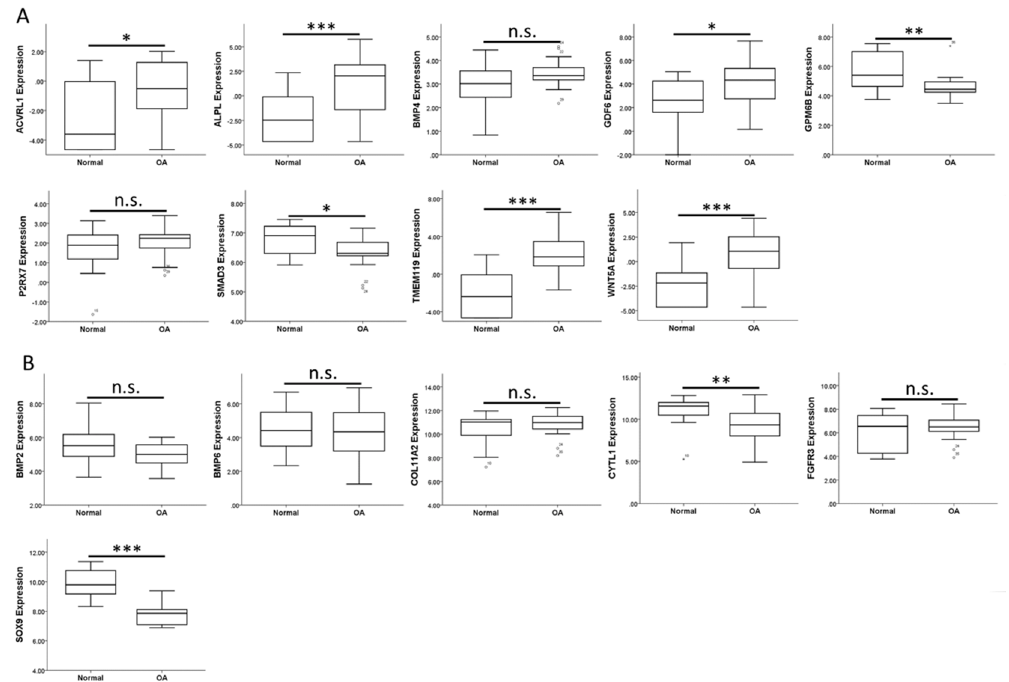
Figure 2. Expression patterns of genes related to the biological processes of OA in the GEO dataset of OA knee cartilages. The expression patterns of ( A ) 9 up-regulated genes and ( B ) 6 down-regulated genes related to biological processes of cellular, tissue and structural changes in OA were analyzed in a GEO dataset of normal and OA knee cartilages (GSE114007). ACVRL1 , ALPL , GDF6 , TMEM119 , and WNT5A were significantly up-regulated, whereas CYTL1 and SOX9 were significantly down-regulated in OA knee cartilages. The expression patterns of GPM6B and SMAD3 (down-regulated) in OA knee cartilage were different from that identified in our expression profile of OA knee chondrocytes (up-regulated). * indicated p < 0.05, ** indicated p < 0.01, *** indicated p < 0.001, and n.s. indicated no statistical significance between normal and OA groups.